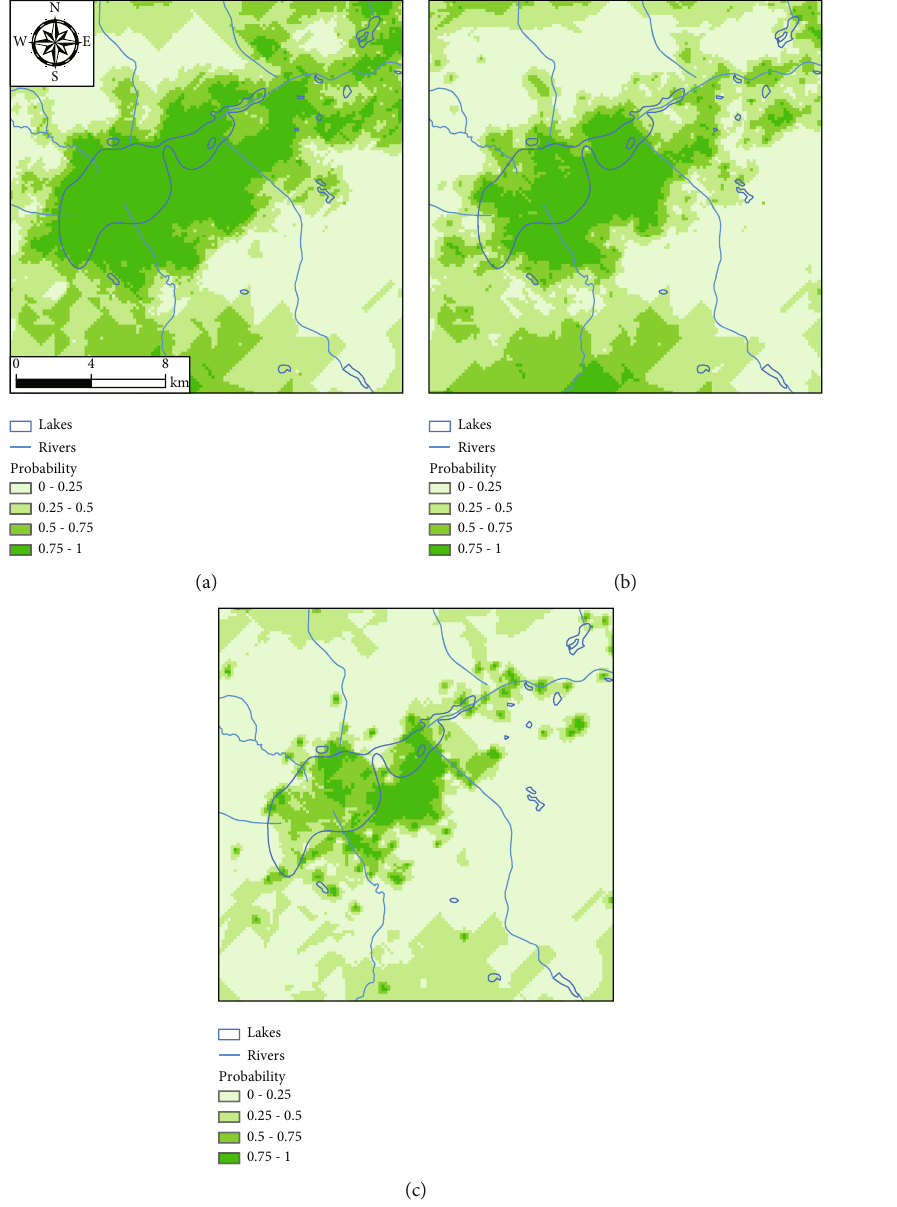
Figure 7: Probability spatial distribution of soil surface salt content under di ff erent thresholds: (a) 0.5%; (b) 1.0%; (c)